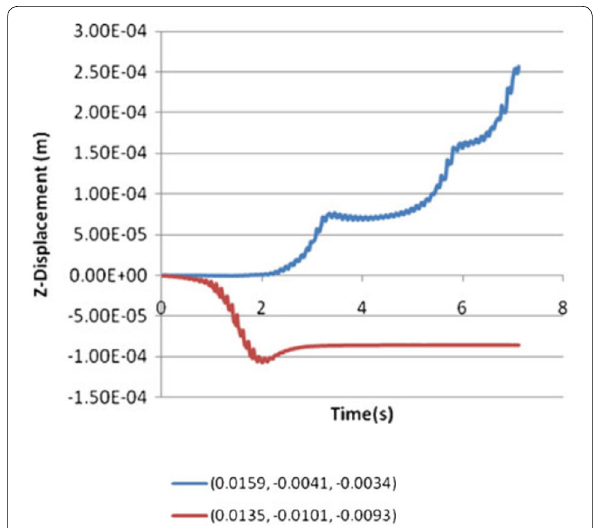
Figure 27 Locations of velocity particles at the middle side of the pin [117]